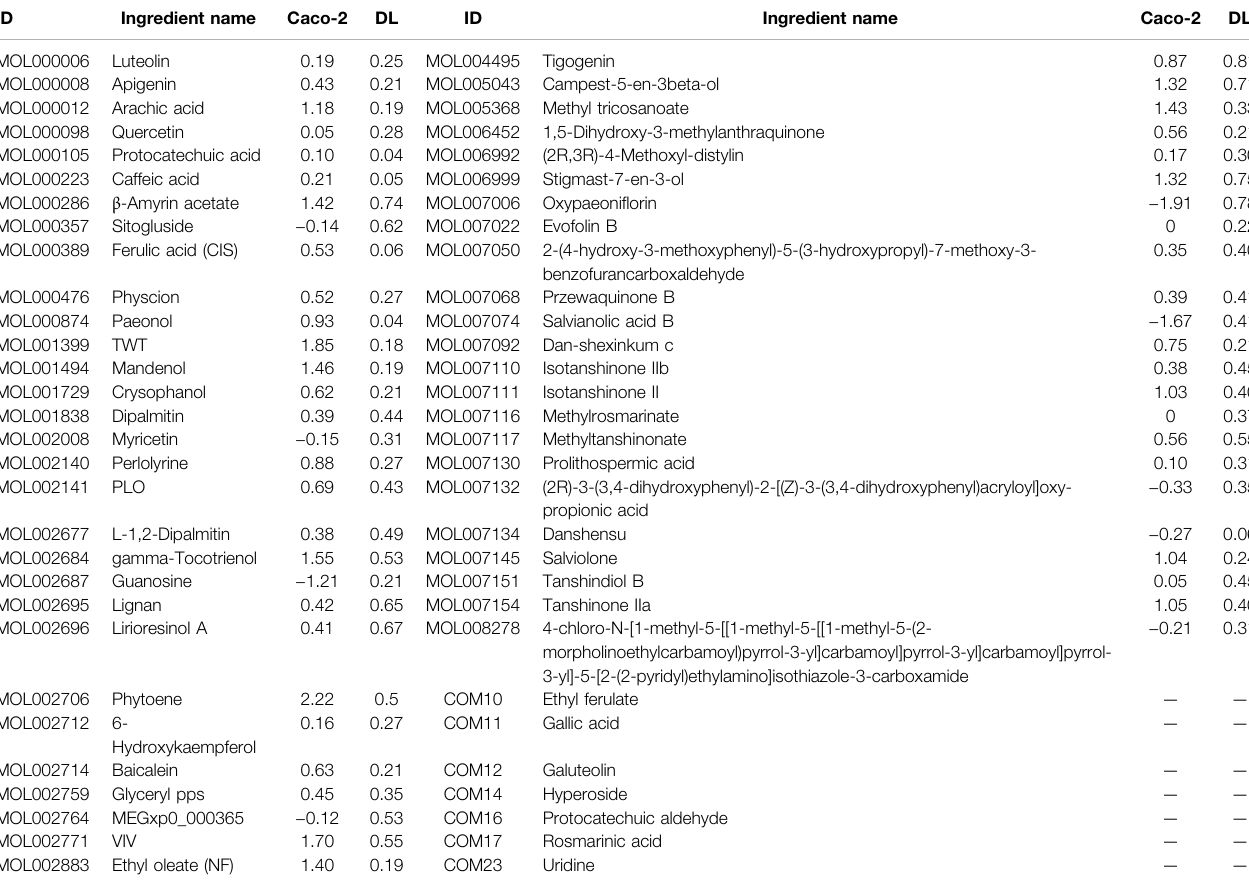
TABLE 3 | Information of the ingredients in CFIG of